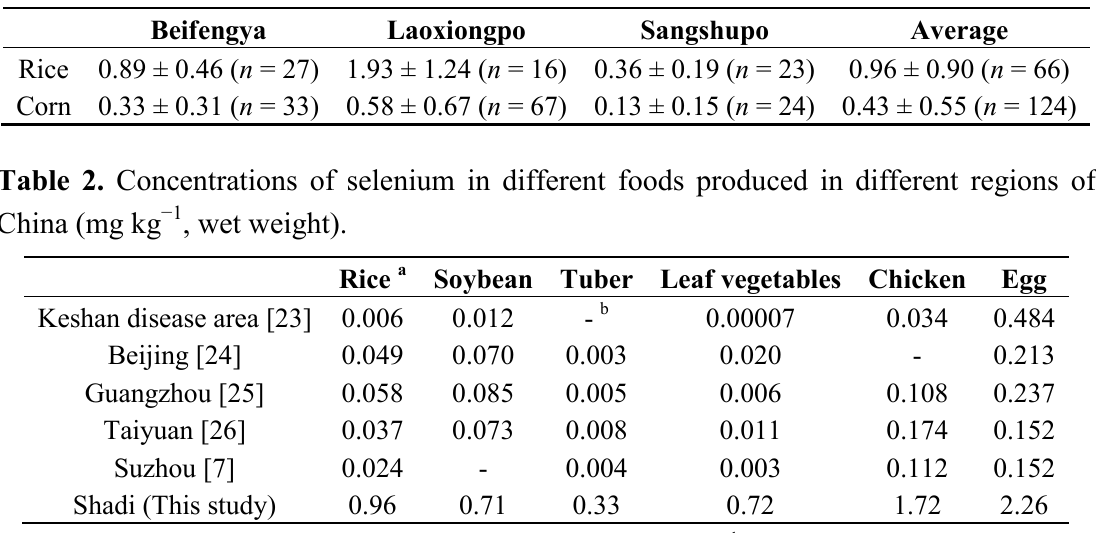
Table 1. Concentrations (mg kg −1 , dry weight) of selenium in corn and rice samples collected from Shadi, Enshi, China.